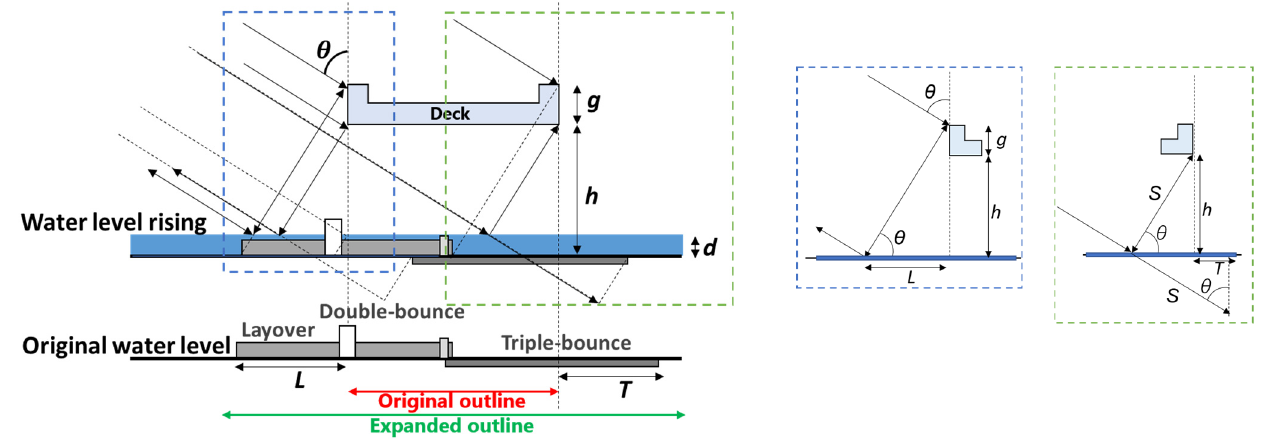
Figure 2. Backscatter models of an over-water bridge under normal and high-water conditions.